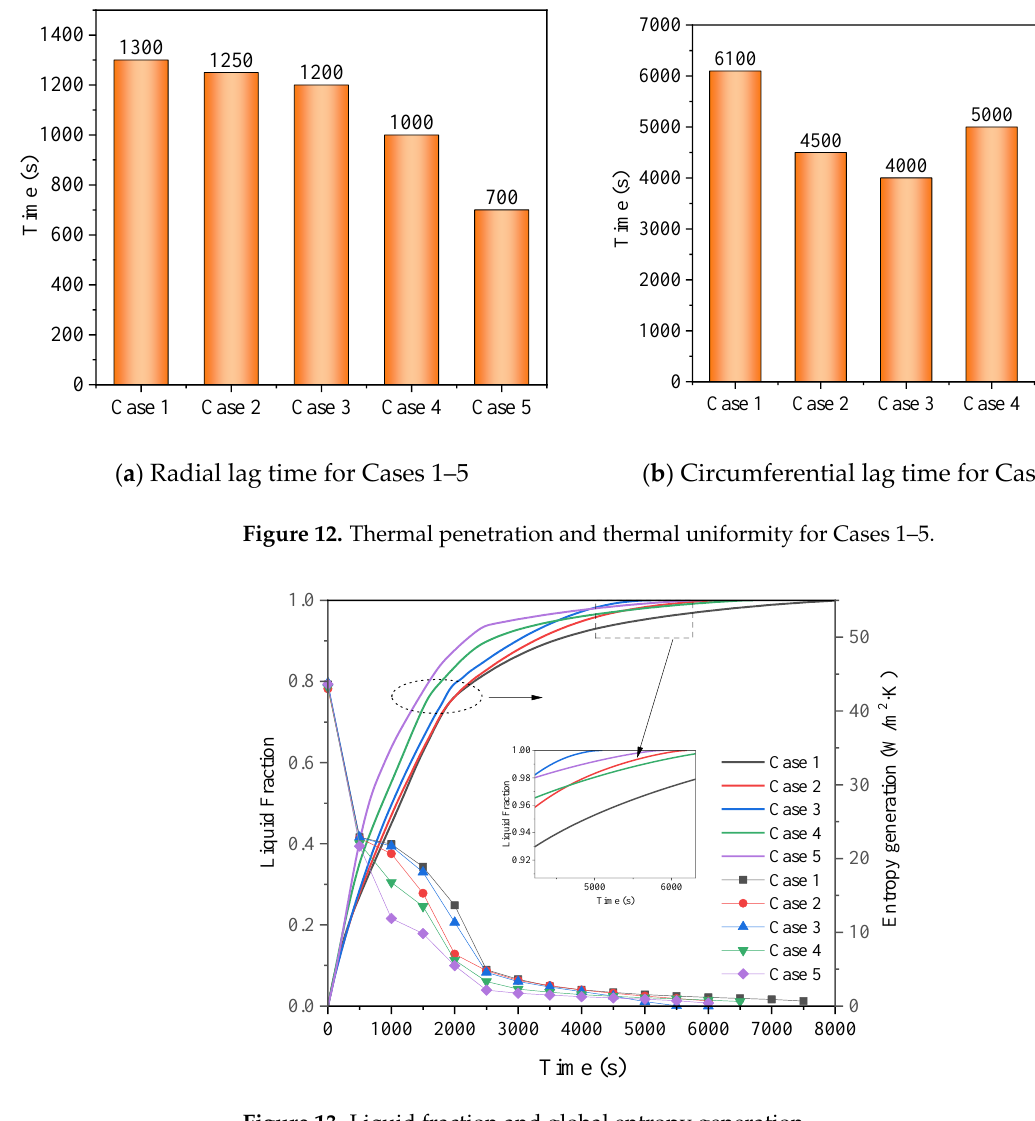
Figure 13. Liquid fraction and global entropy generation.